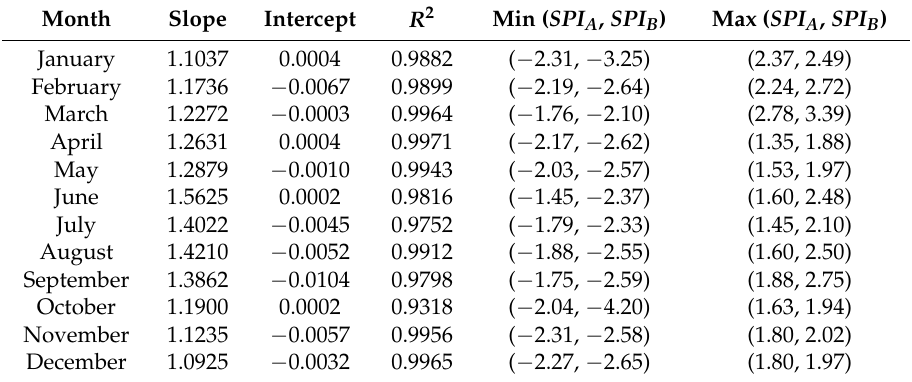
Table 6. The linear relationship of SPI series from two processing schemes (independent variable: SPI series obtained from precipitation-mean scheme, dependent variable: SPI series captured from SPI-mean scheme).